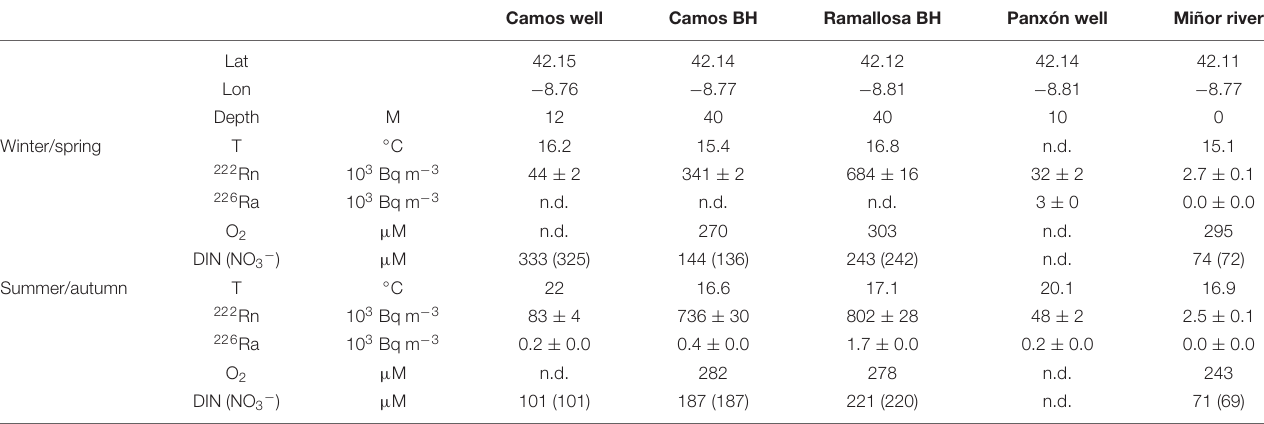
TABLE 1 | Temperature, 222 Rn and 226 Ra activities, dissolved oxygen, dissolved inorganic nitrogen (DIN = NH 4 + + NO 2 − + NO 3 − ) and NO 3 − in the Miñor river, wells and boreholes surrounding the sampling beaches during winter/spring and